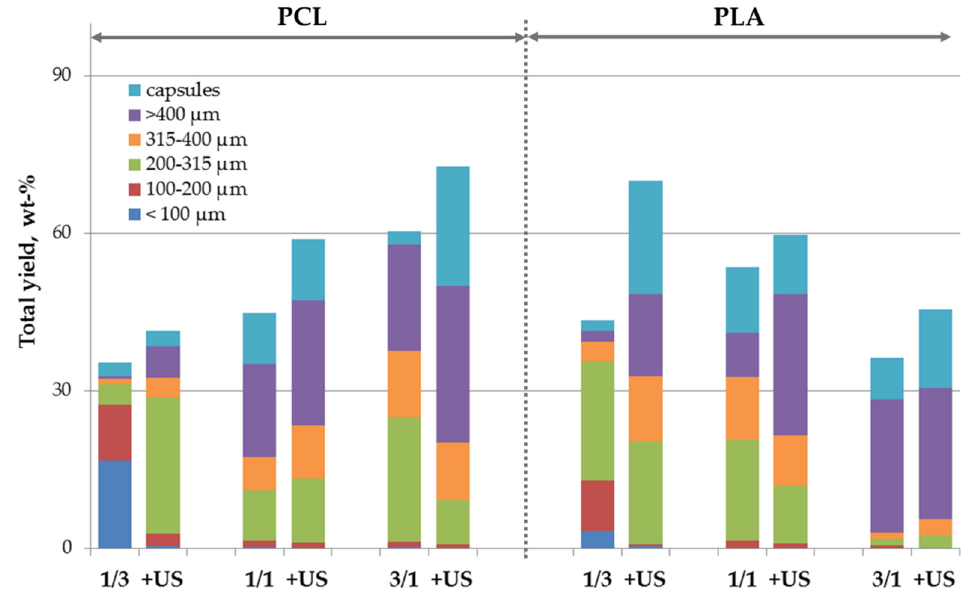
Figure 8. Effect of pre-treatment conditions, composition, and nature of the polymer dissolved within oil phase on the processing yield and size distribution of the polymeric microparticles filled with nHA. Polymer/nHA ratio in the oil phase is indicated below; +US—additional ultrasound treatment of the oil phase.